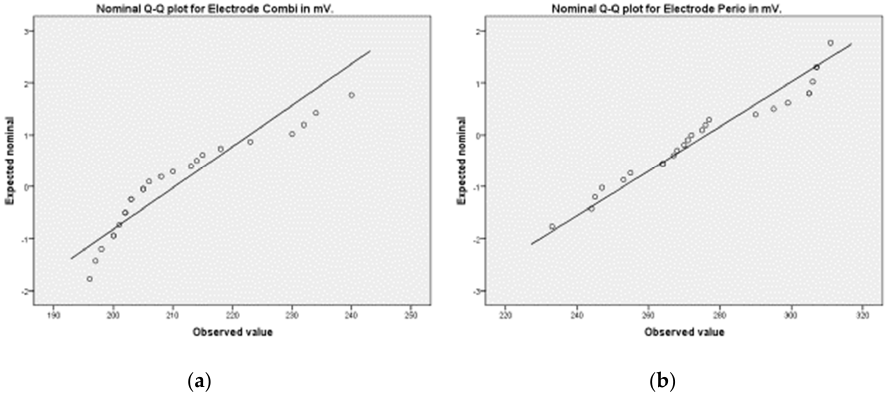
Figure 5. Statistics, Q-Q(quantile-quantile) plots play a ital role to graphically analyze and compare two probability distributions Normal Q–Q plot. ( a ) Normal distribution of the combination electrode potential in mV. ( b ) Normal distribution of the periodontic electrode potential in mV. The box plots of the electrodes show a wider dispersion for the periodontic electrode potential, but the values are higher than those of the combined electrode (Figure 6).